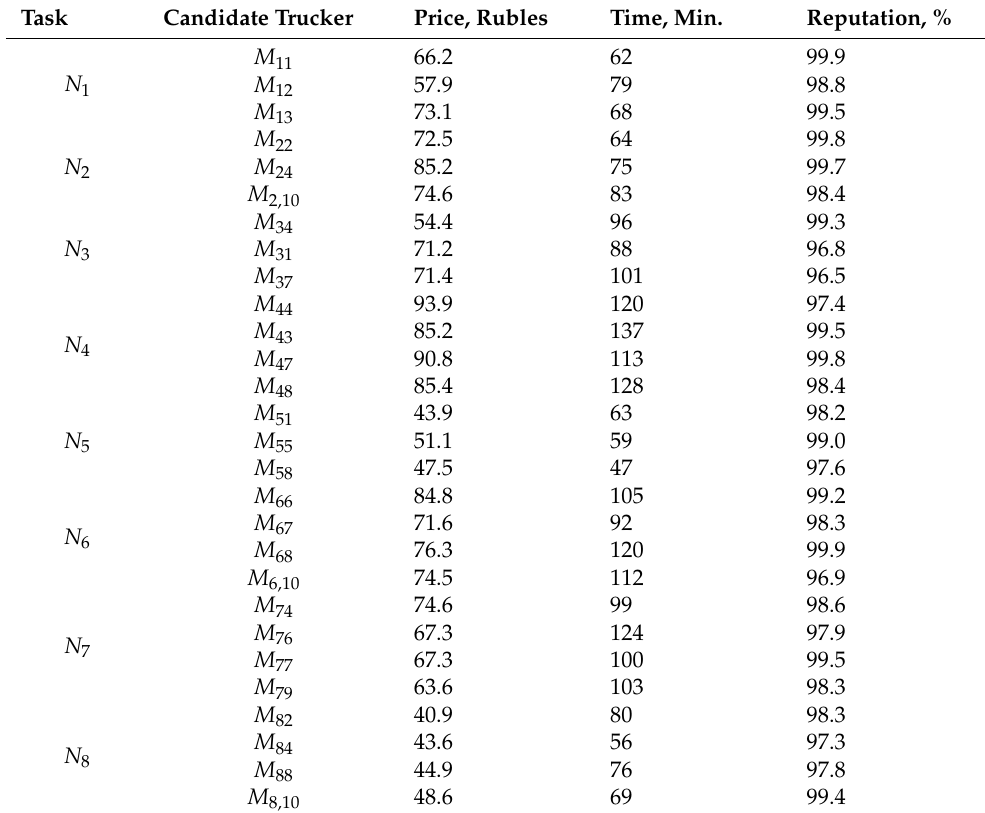
Table 4. Parameters of truck delivery.